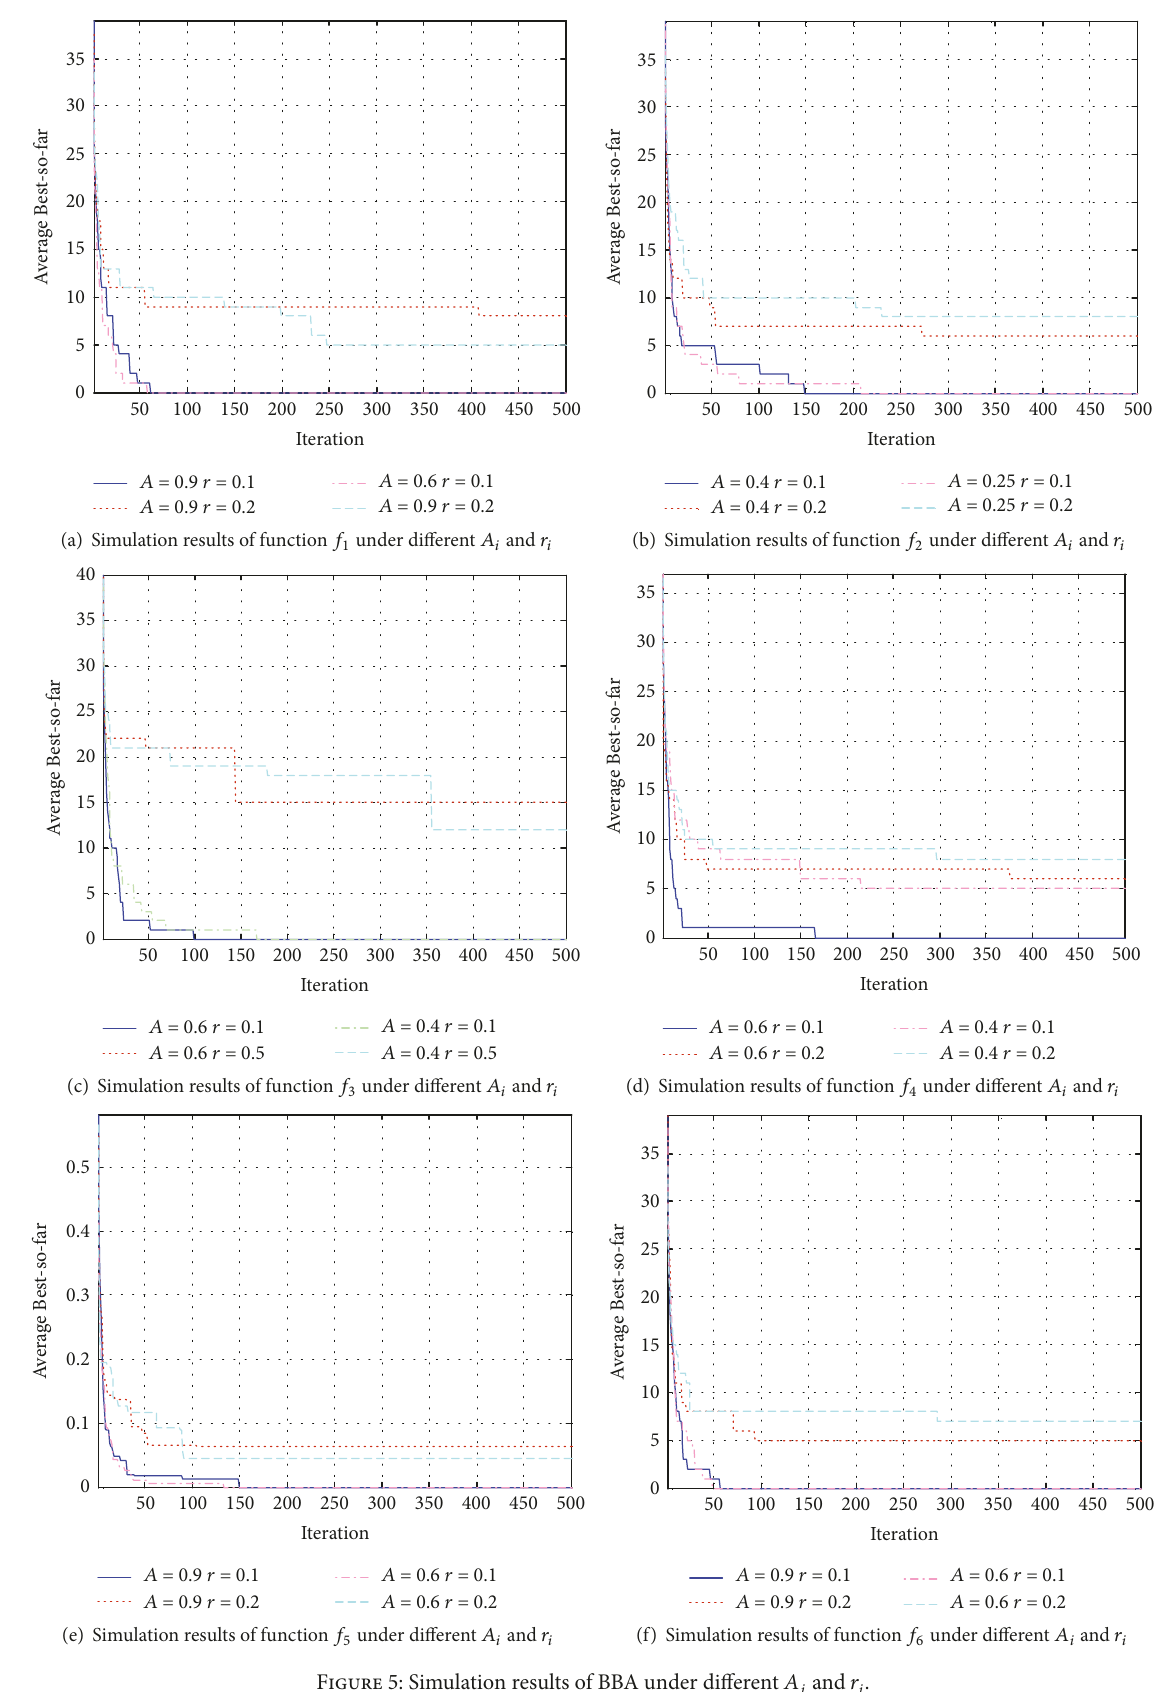
Figure 5: Simulation results of BBA under different 𝐴 𝑖 and 𝑟 𝑖